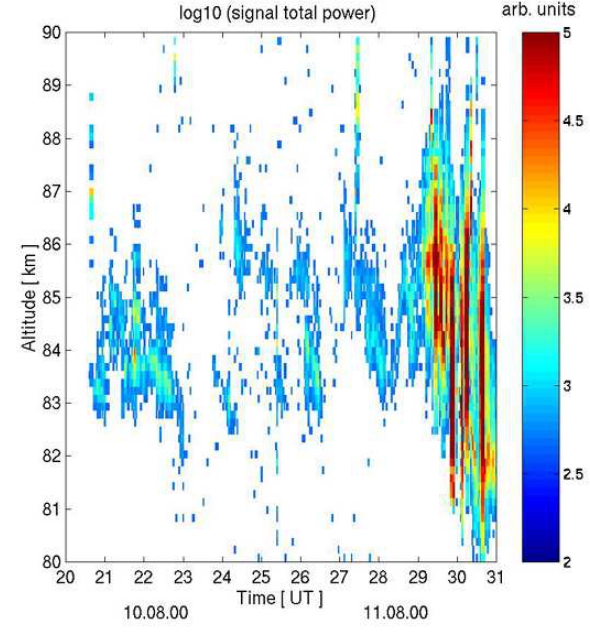
Fig. 5. Height-time distribution of the PMSE occurrence as the signal power at 2-min and 150-m